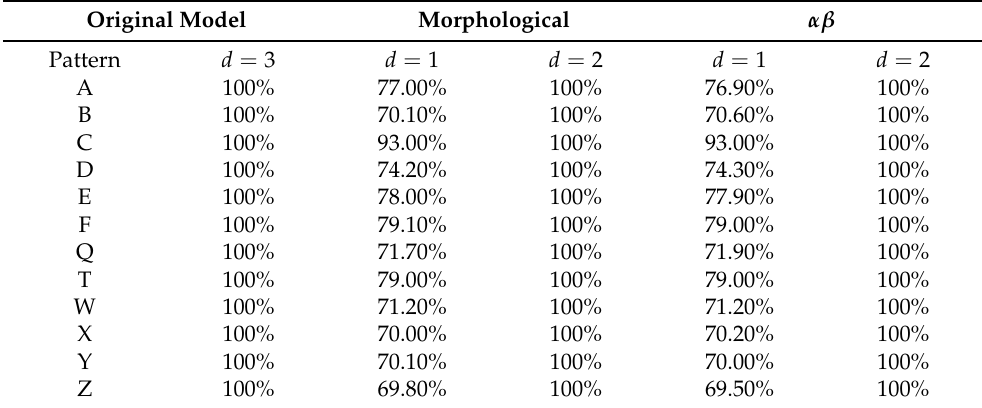
Table 5. Performance of the proposed model vs. original model in 50 × 50 binary images. Original Model